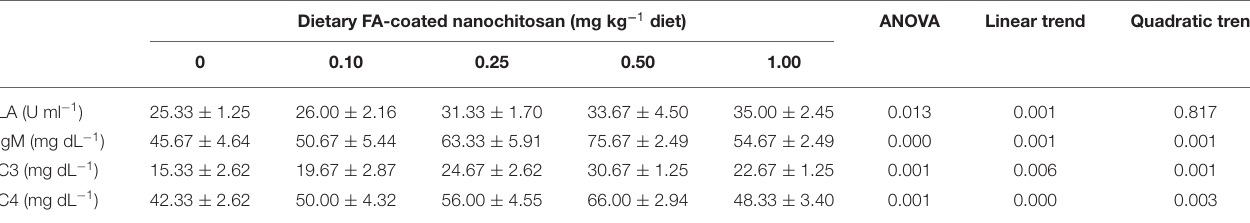
TABLE 5 | Immune response of fingerling rainbow trout, Oncorhynchus mykiss , fed diets containing varying levels of folic acid-coated nanochitosan*. Dietary FA-coated nanochitosan (mg kg − 1